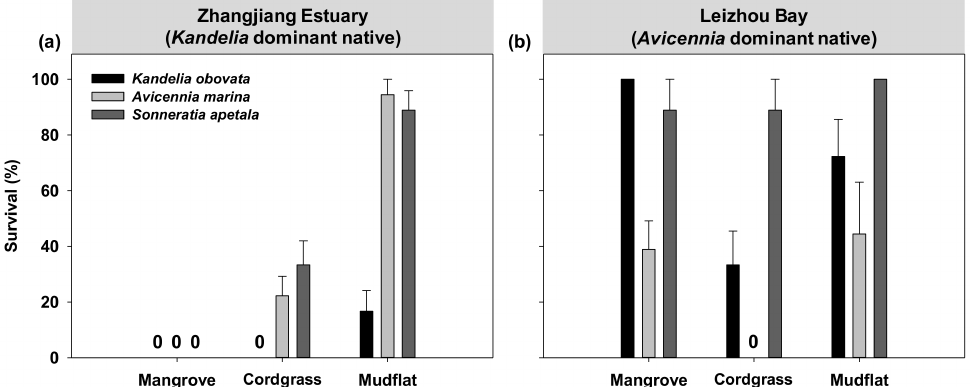
Figure 2. Seedling survival over two growing seasons in three habitats in ( a ) Zhangjiang Estuary and ( b ) Leizhou Bay. Data are means + SE ( n = 6 per treatment). All main effects (site, species, habitat) and all two-way interactions affected mangrove survival (Supplementary Table S3).